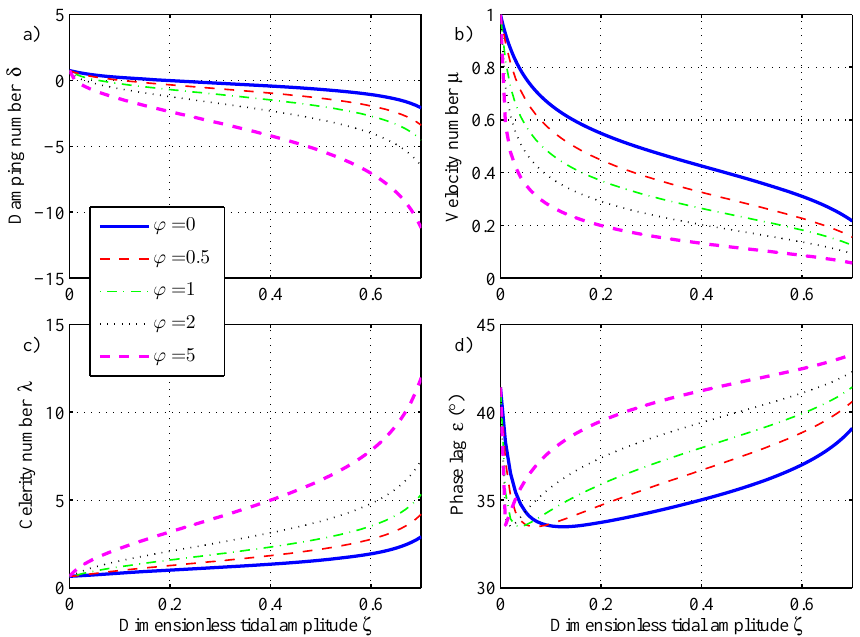
Fig. 6. Relationship between the main dimensionless parameters and the dimensionless tidal amplitude ζ obtained by solving the Eqs. (11) (with 0 = 0 H ), (30) and (31) for different values of the dimensionless river discharge term ϕ with χ 0 =20, γ =1.5 and r S =1, where χ 0 is defined with Eq. (36).